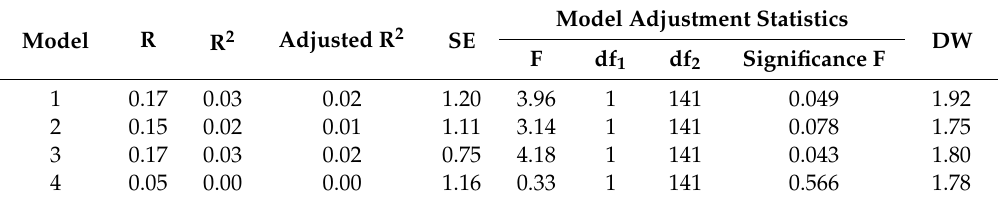
Table 5. Impact of professional experience on individual UTAUT